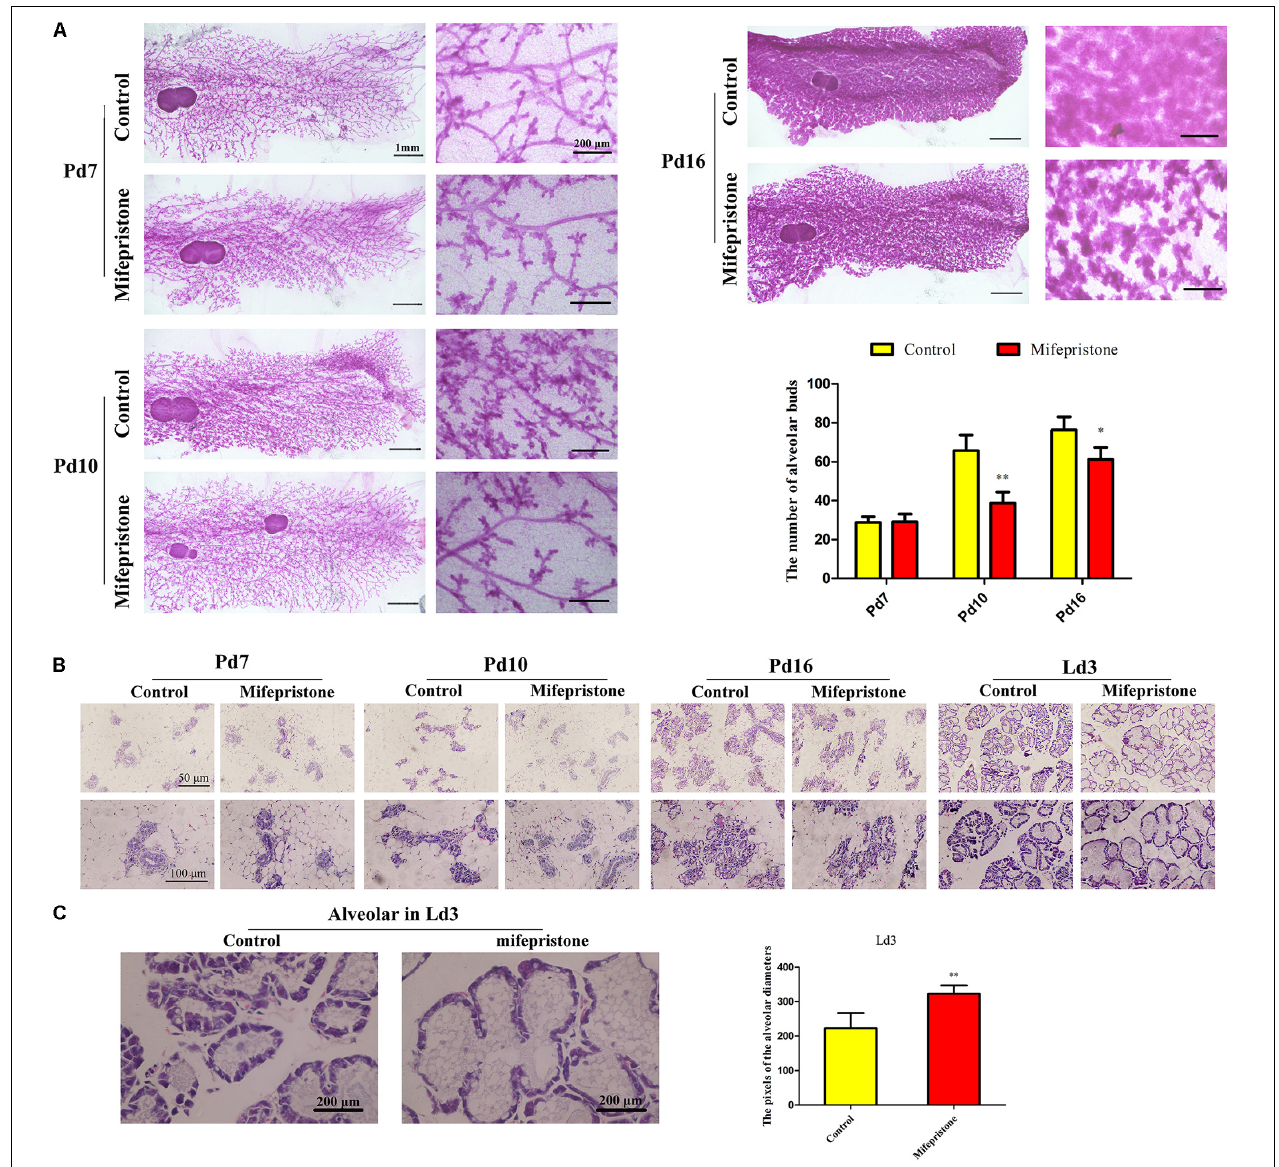
FIGURE 4 | The effect of mifepristone administration on pregnancy day 4 (Pd4) on mammary branching and alveoli formation. (A) Whole-mount staining of mammary glands of mice on Pd7, Pd10, and Pd16. Quantification of the number alveolar buds in mammary glands of controls and mifepristone-treated mice. (B) Hematoxylin and eosin (H&E) staining of mice mammary glands on Pd7, Pd10, Pd16, and lactation day 3 (Ld3). (C) The quantification of alveolar diameters on Ld3. Data are represented as means ± SD, ∗ indicates the difference between mifepristone group and control group, ∗ P < 0.05, ∗∗ P <